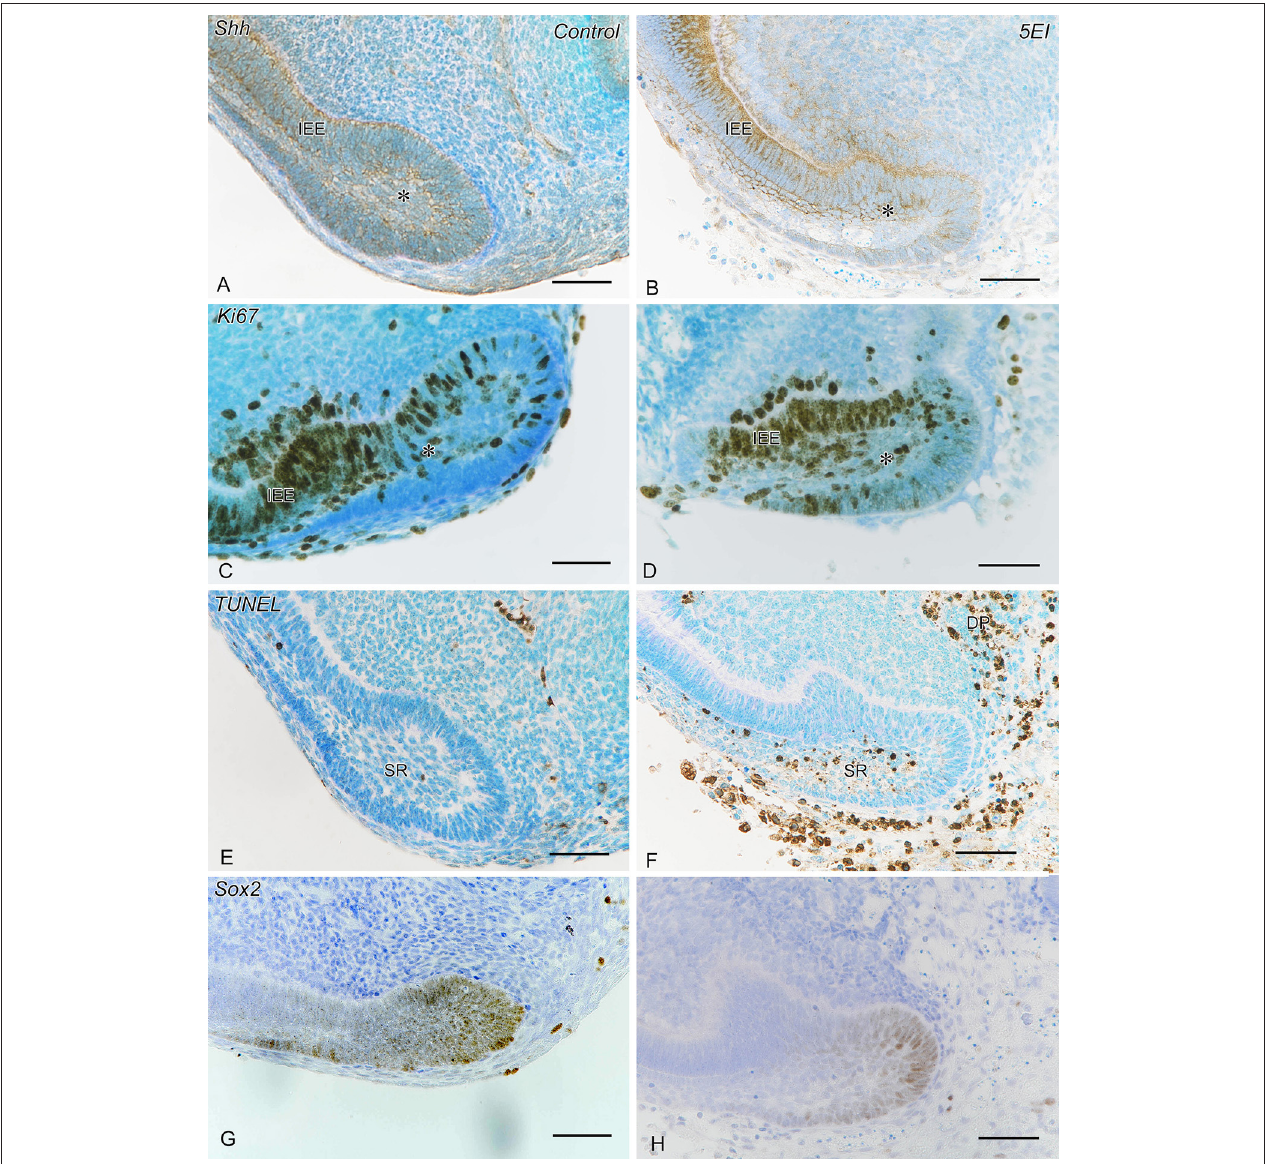
FIGURE 4 | Shh IR (A,B) , Ki67 IR (C,D) , terminal deoxynucleotidyl transferase-mediated dUTP nick end labeling (TUNEL) (E,F) , and Sox2 IR (G,H) in control (A,C,E,G) and experimental (Shh antibody: 5E1) explants (B,D,F,H) . (A–D) Shh expression and Ki67 + cells are observed in the apical bud (*) and the inner enamel epithelium ( IEE ) in both the control and 5E1 groups. (E,F) TUNEL + cells of stellate reticulum ( SR ) and dental papilla ( DP ) increase in number in the 5E1 group compared with those in the control. (G,H) Sox2 + cells decrease in number in the 5E1 group compared with those in the control. Scale bars: 50 µ m.